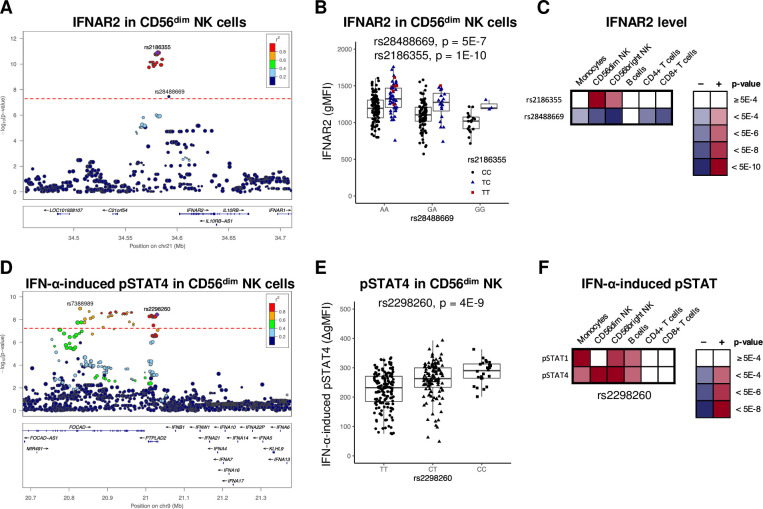
Cell-type and trait specific effects of pQTLs.(A-C) Data on IFNAR2 cell surface levels. (A) Regional association plot for IFNAR2 surface levels in CD56dim NK cell and (B) boxplots stratified by rs28488669 and rs2186355. (C) Heat-map of the relation between p-values for the two cis-IFNAR2 pQTLs in different cell-types as specified. (D-E) Data on IFN-α induced phosphorylation of STAT4 (pSTAT4) and STAT1 (pSTAT1). (D) Regional association plot of the IFN-α induced pSTAT4 in CD56dim NK cells and (E) boxplots stratified by rs2298260. (F) Heat-map of the relation between pQTL p-values for IFN-α induced pSTAT1 and pSTAT4 in indicated cell-types. (A and D) The genome-wide significance level (p < 5.0E-8) is denoted by a red line. (A-F) p-values from the full model using single (A, D-F), or two additive SNPs (B-C), (n = 303). Boxplots show median, IQR and range. gMFI = geometric mean fluorescence intensity.